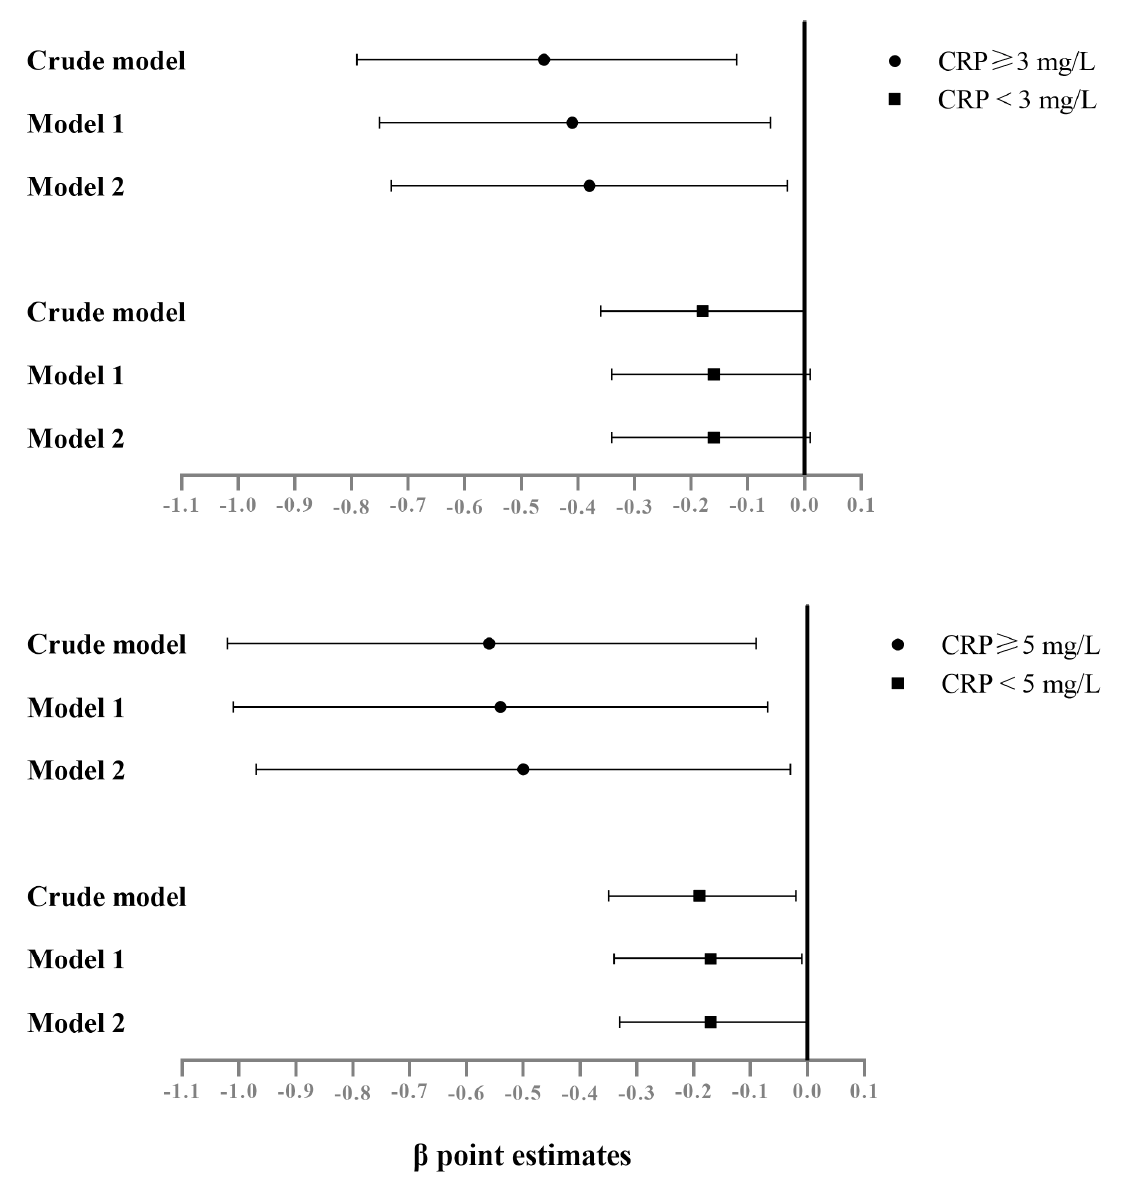
Figure 1. Forest plot for β (regression coefficients) of depression with serum Mg levels, categorized by different CRP levels, NAHSIT 2005–2008. The error bars indicate a 95% CI. Model 1 was adjusted for age and sex. Model 2 was adjusted for statistically significant variables ( p < 0.05) in the univariate analysis (Table 1). Table 3. Odds ratios and estimates of depression scores according to serum Mg levels by CRP levels, NAHSIT 2005–2008.